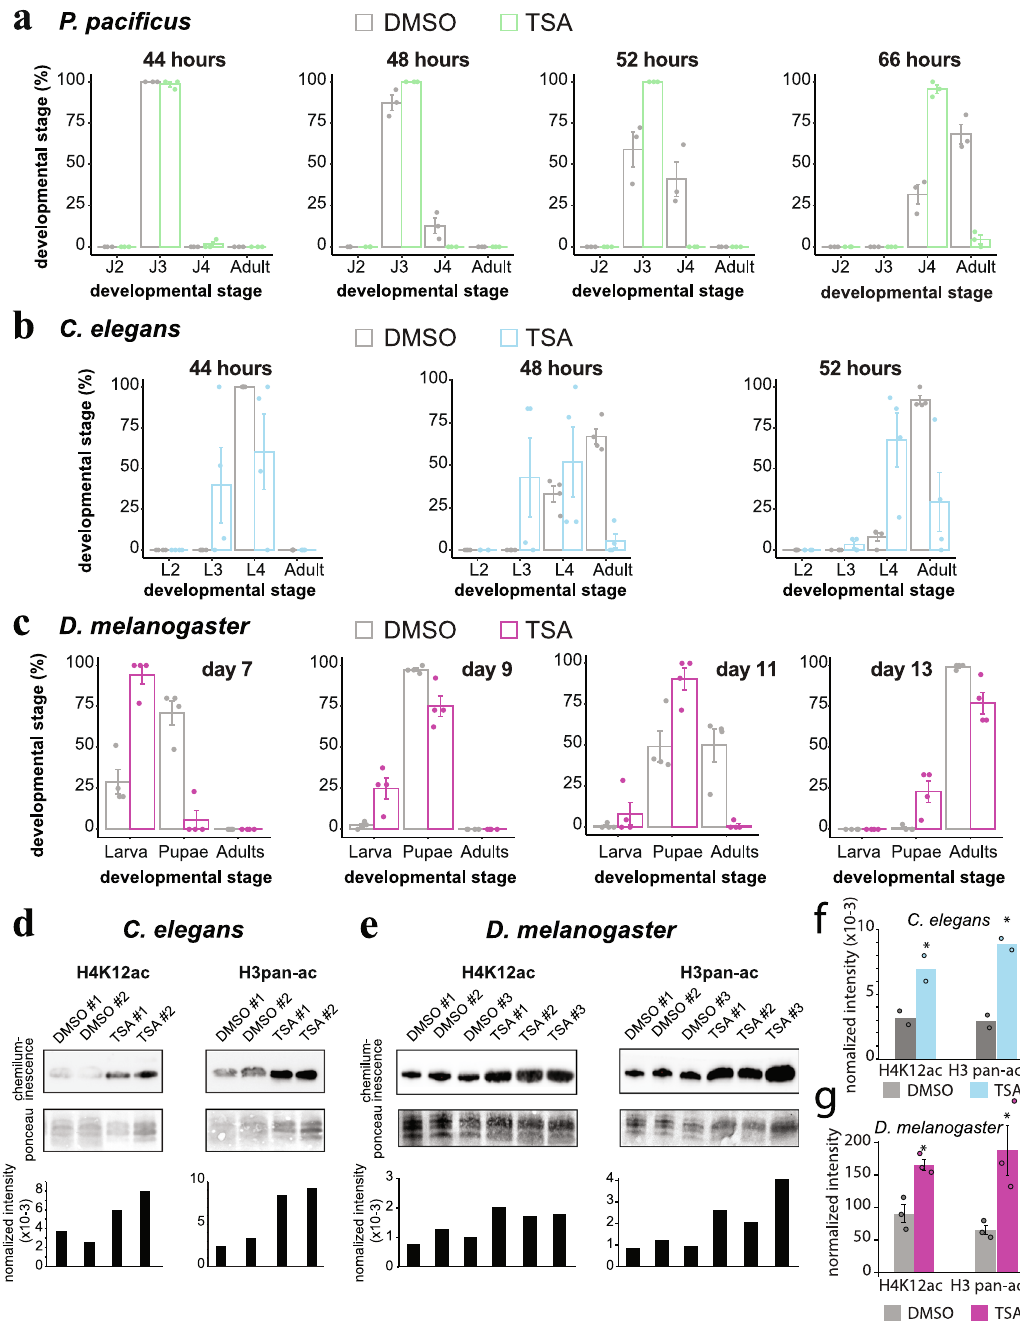
Fig. 5 | Histone acetylation links plasticity to developmental speed. a Developmental rate of P. paci fi cus , b C. elegans , and c , D. melanogaster +/- TSA, n =3biologicallyindependentpopulationsof P.paci fi cus ,4for C.elegans ,and4for D. melanogaster . Signi fi cance was assessed with a two-way ANOVA. Error bars represent S.E.M. d Representative WBs of acid-extracted histones from C. elegans and e D. melanogaster . Intensity of chemiluminescence was normalized to total